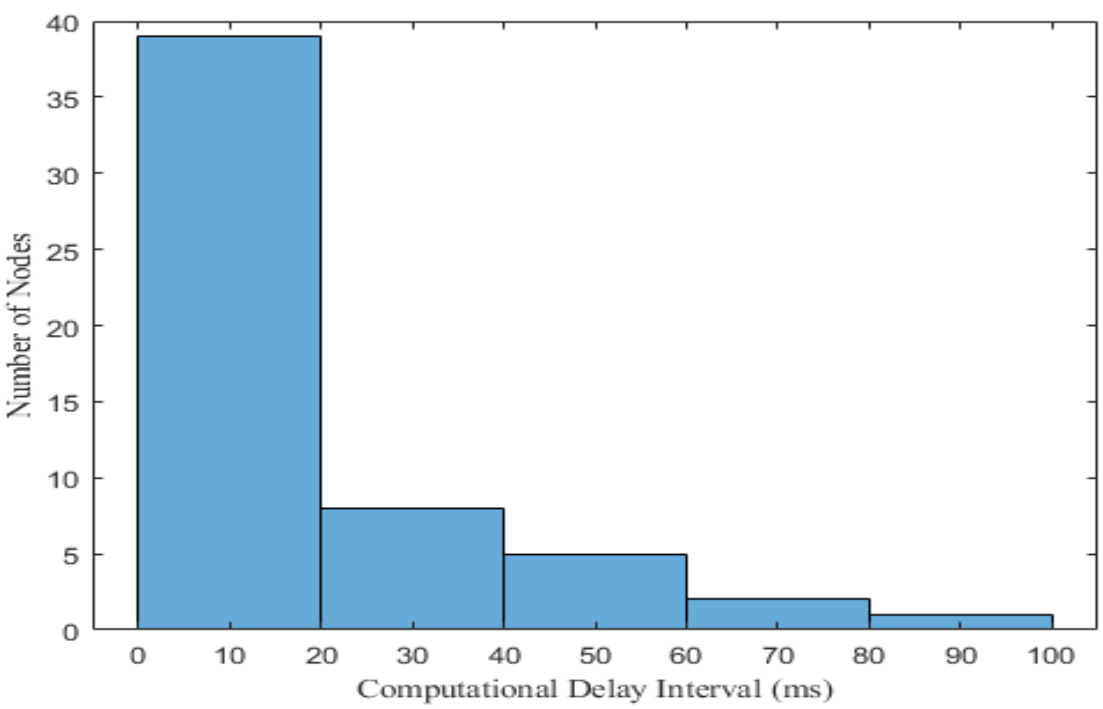
Figure 9. Histogram view of computational delay over node execution among existing algorithms and BDPS.